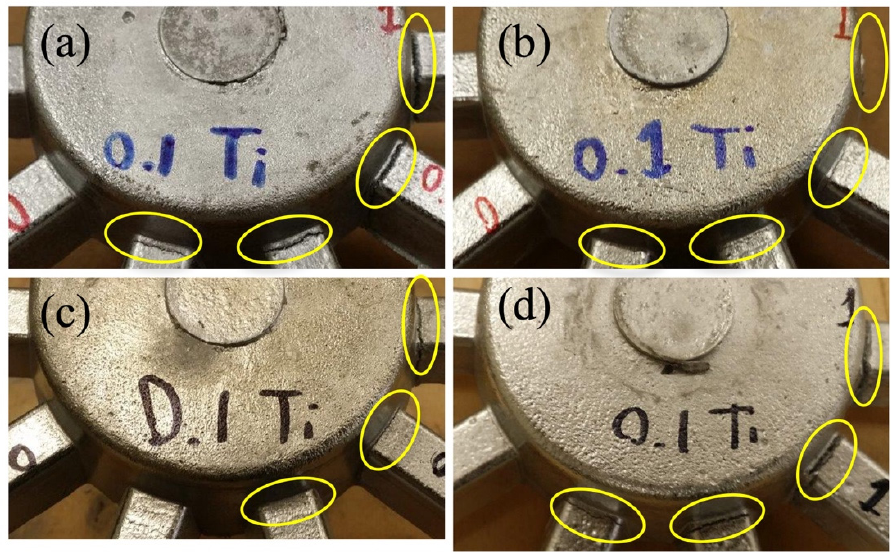
Figure 6. Pictures of representative multi-arm castings with 0.02 wt.% Ti addition: ( a ) DA1, ( b ) DA2, ( c ) DA5, ( d ) DA6, and ( e ) DA7.